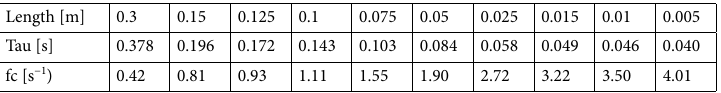
Table 1. Dependence of low-pass filter corner frequency (fc) from tube length and tau.